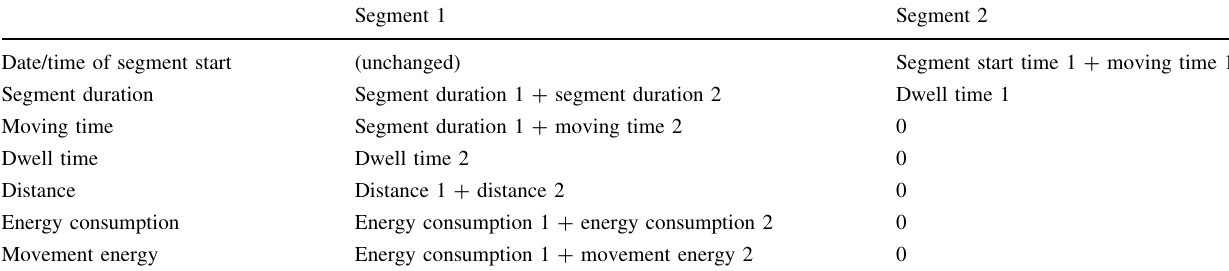
Table 2 Changes to index file for an in-segment stop